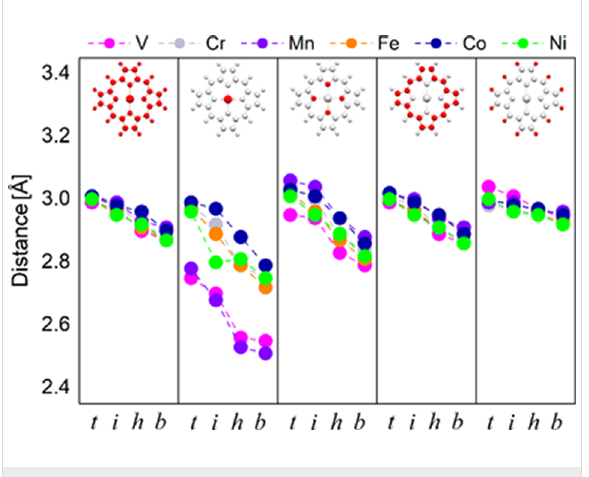
Figure 1: Graphic representation of the molecule–surface distances for all chemical species in TMPP. The images at the top indicate from left to right: the whole molecule, the transition-metal atom, N, C and H. The positions of the TM atom on top of Ag(111) are labeled as “ t ” (top), “ i ”(intermediate), “ h ”(hollow) and “ b ”